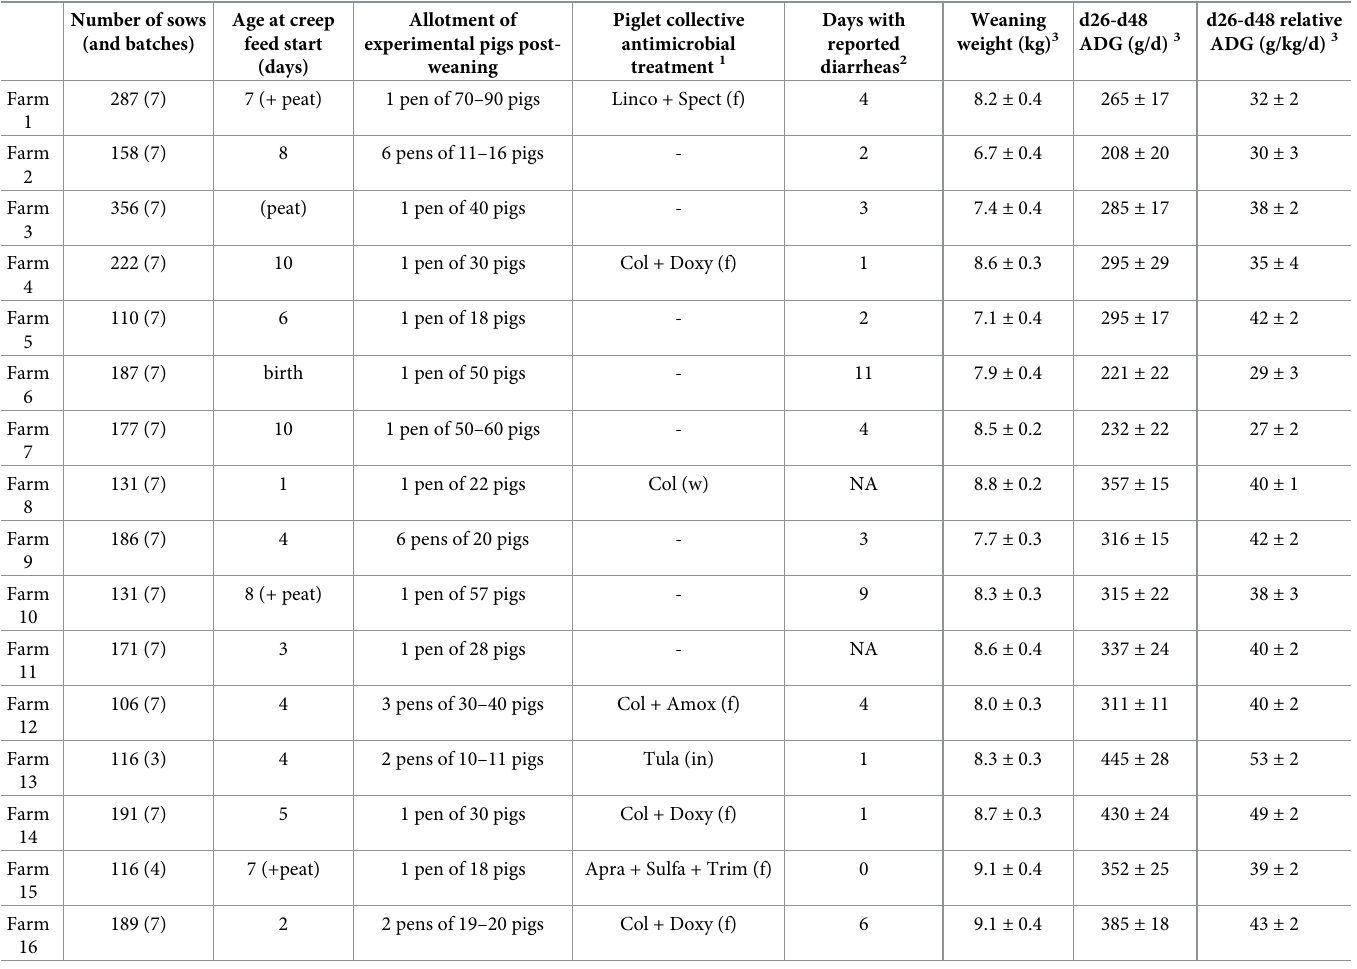
Table 1. Characterization of the farms, practices, and treatments during the study, and growth of animals involved in the study. Number of sows (and